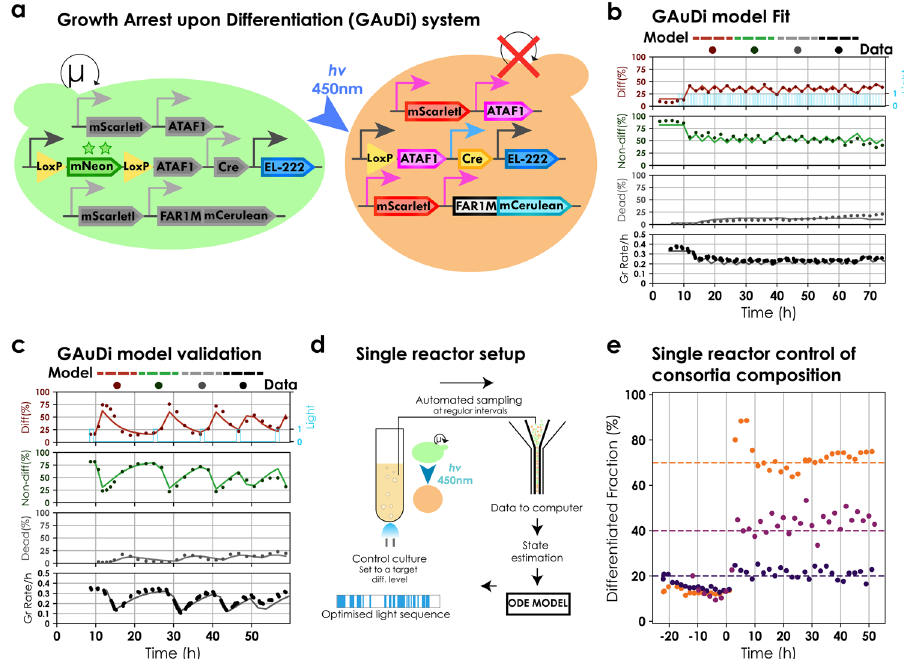
Fig. 4 Characterization and modelling of GAuDi. a Design. GAuDi cells constitutively express EL222. Blue light triggers expression of Cre and recombination, and expression of ATAF1 transcription factor. ATAF1 drives the overexpression of a FAR1 mutant (that arrests cells in G1) and mScarlet-I, a “ marker ” for differentiation. An additional copy of ATAF1 driving itself was necessary for effective arrest. b GAuDi ODE model fi t. An ODE model for GAuDi was developed phenomenologically. The model was fi tted to dynamical data with repeated light stimuli of different durations. Solid circles represent data and solid lines signify model predictions. We note that before t = 0, a persistent non-zero differentiation fraction was present possibly due to leakiness in ATAF1 expression in a subset of the population (Supplementary Note 4). c GAuDi model validation. The fi tted model was validated by predicting dynamic responses to light signals that were not used for the fi t. Data are represented as in ( b ). Globally, model predictions were in good agreement with the data (Supplementary Fig. 15). d Setup for single reactor control. Cells harbouring the GAuDi system were continuously cultured in the exponential phase. The culture was set to a target level of differentiation and continuously monitored via automated fl ow cytometry measurements that were analysed online. The system state was estimated from analysed data and sent to the model predictive control (MPC) module. The MPC module provided an optimized light sequence to maintain the culture at the desired set point (Supplementary Note 5). Due to presence of dead cells, data were fi ltered and only live cells were used for subsequent analysis. e Single reactor, single strain control of a microbial consortium. Cultures were targeted to 25, 40, and 70% differentiation. Control started at t = 0 h. Circles signify differentiated fractions. Each colour corresponds to a different control experiment and the dashed line re fl ects the target set